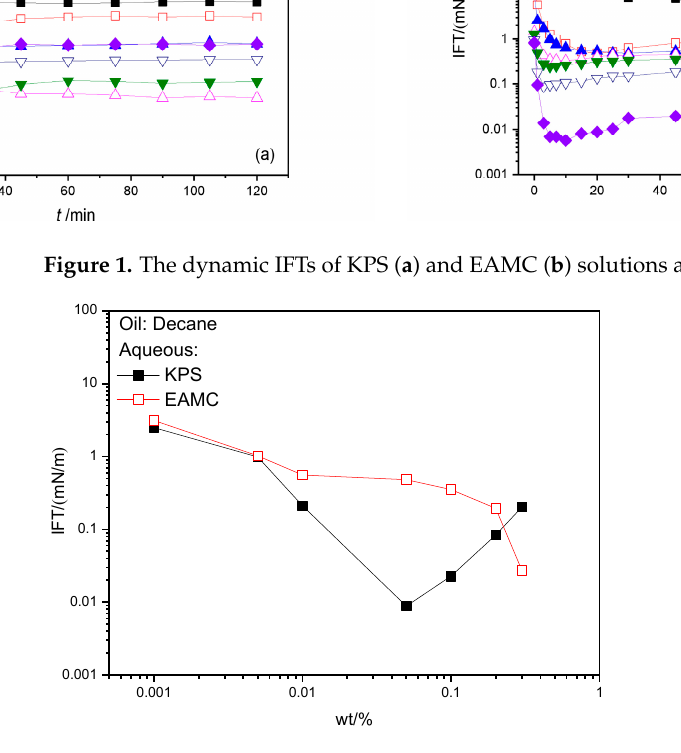
Figure 2. Effect of concentration on the equilibrium IFTs of KPS and EAMC solutions.